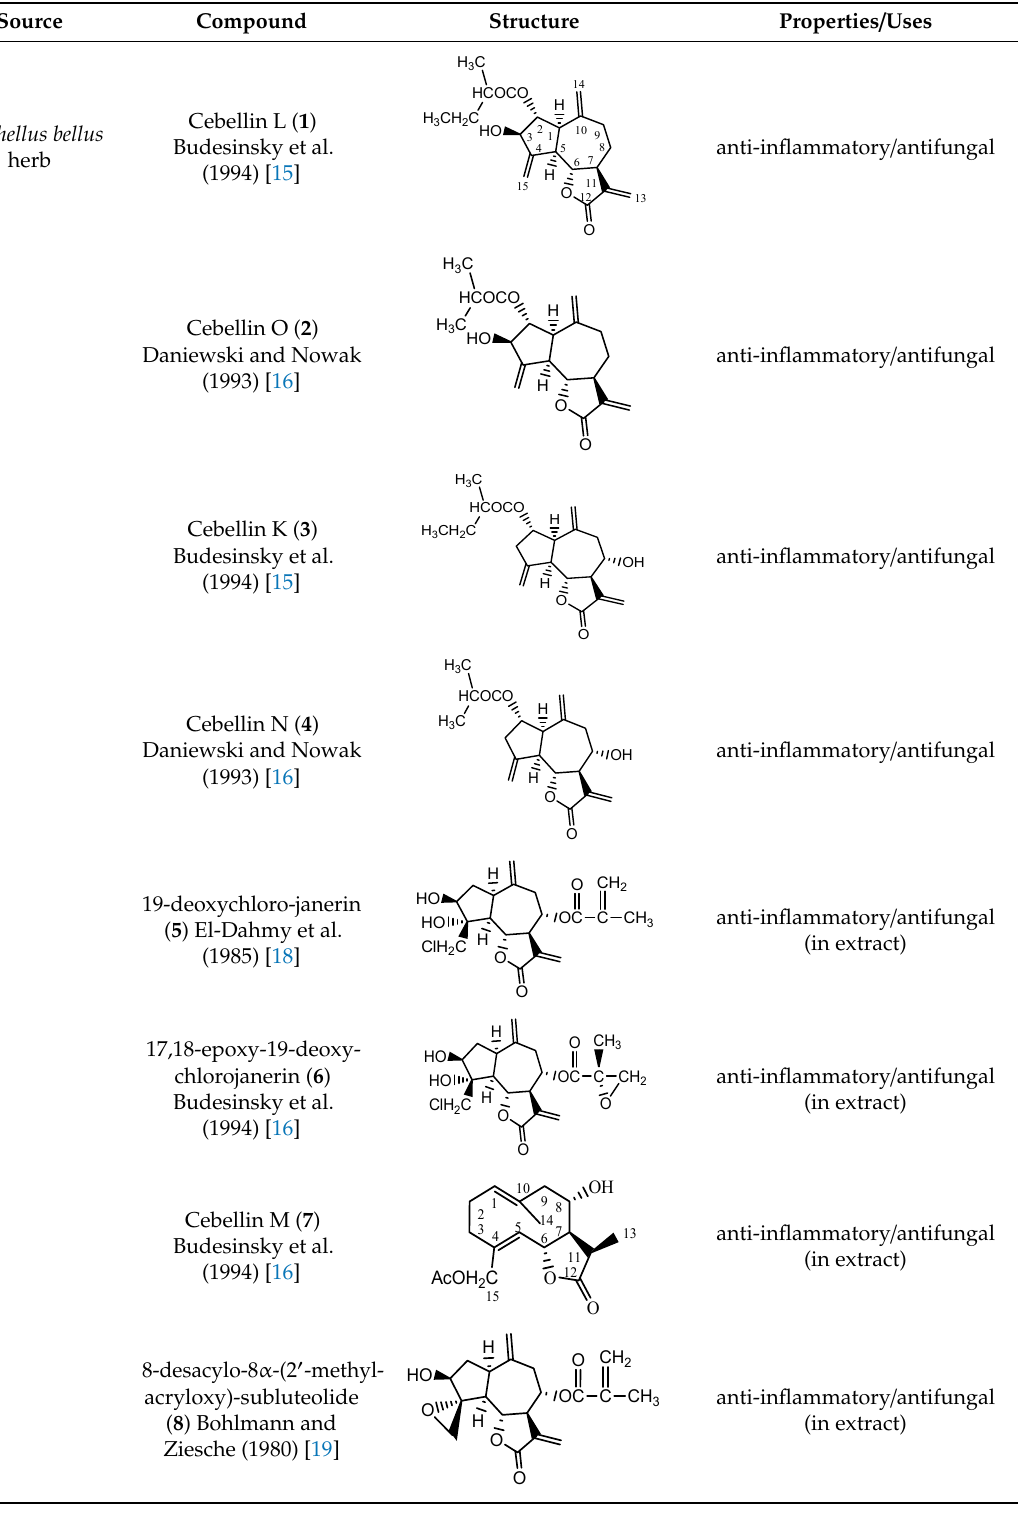
Table 1. Pharmacological properties of the compounds and the extracts from selected plants of Centaureinae subtribe.